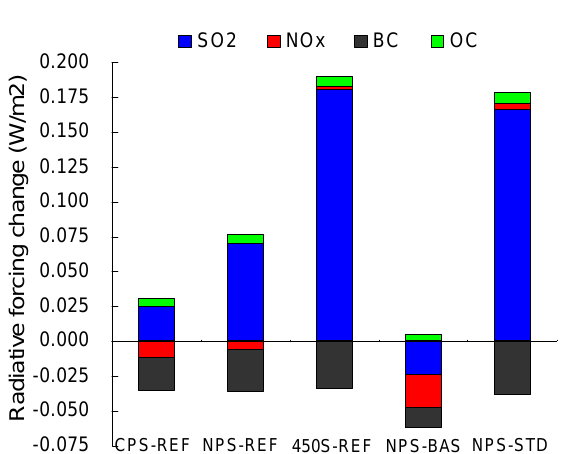
Figure 7. Effects of changes in China’s emissions of air pollutants from 2005 to 2030 on radiative forcing for selected scenarios ana- lyzed in this